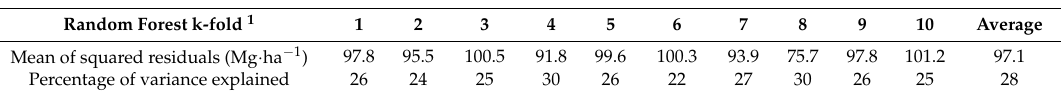
Table 2. Random Forest model performance (mean squared residuals and percentage of variance explained for each of the 10 k-fold random forest models).